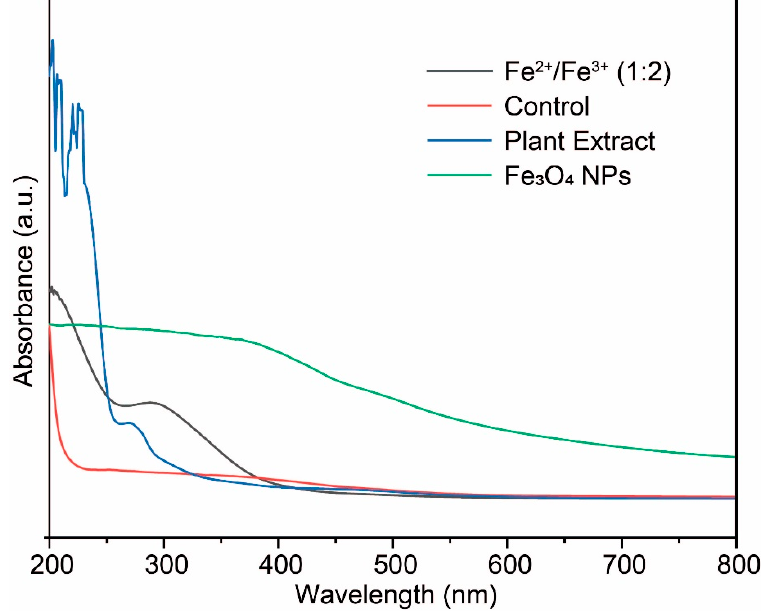
Figure 2. UV − Vis spectrum of Fe 2+/ Fe 3+ (1:2), control, B. ramiflora leaves extract and synthesized Fe 3 O 4 NPs.